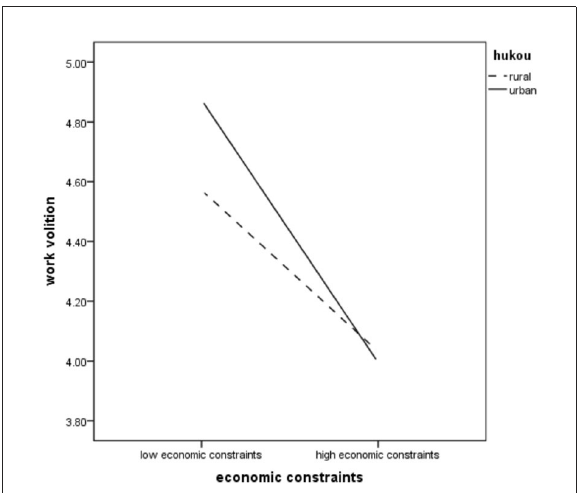
FIGURE2 Hukou moderating the relation between economic constraints and work volition.